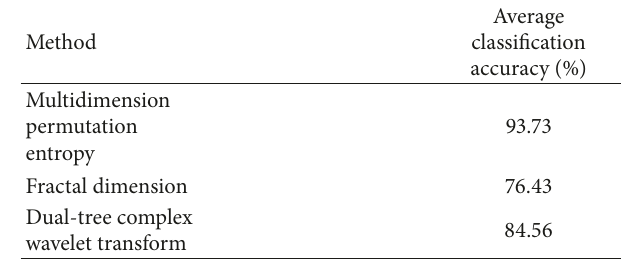
Table 3: Comparing classification